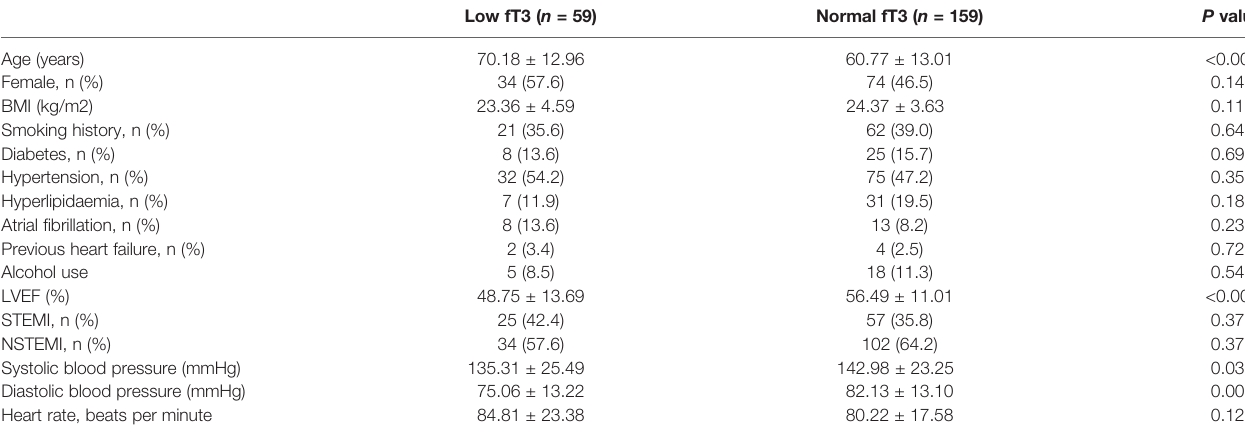
TABLE 1 | Baseline characteristics of the study